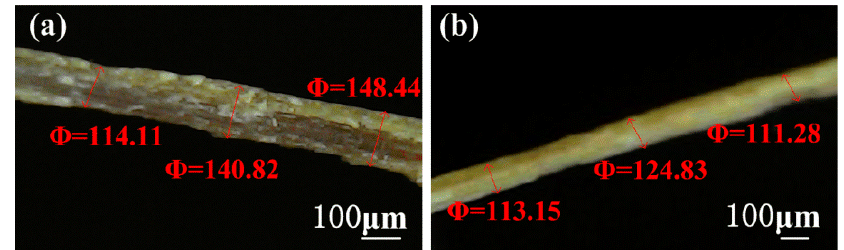
Figure 2. Measurement of diameters of untreated bamboo fiber ( a ) and 6 wt.% NaOH treated bamboo fiber ( b ) by optical microscope.